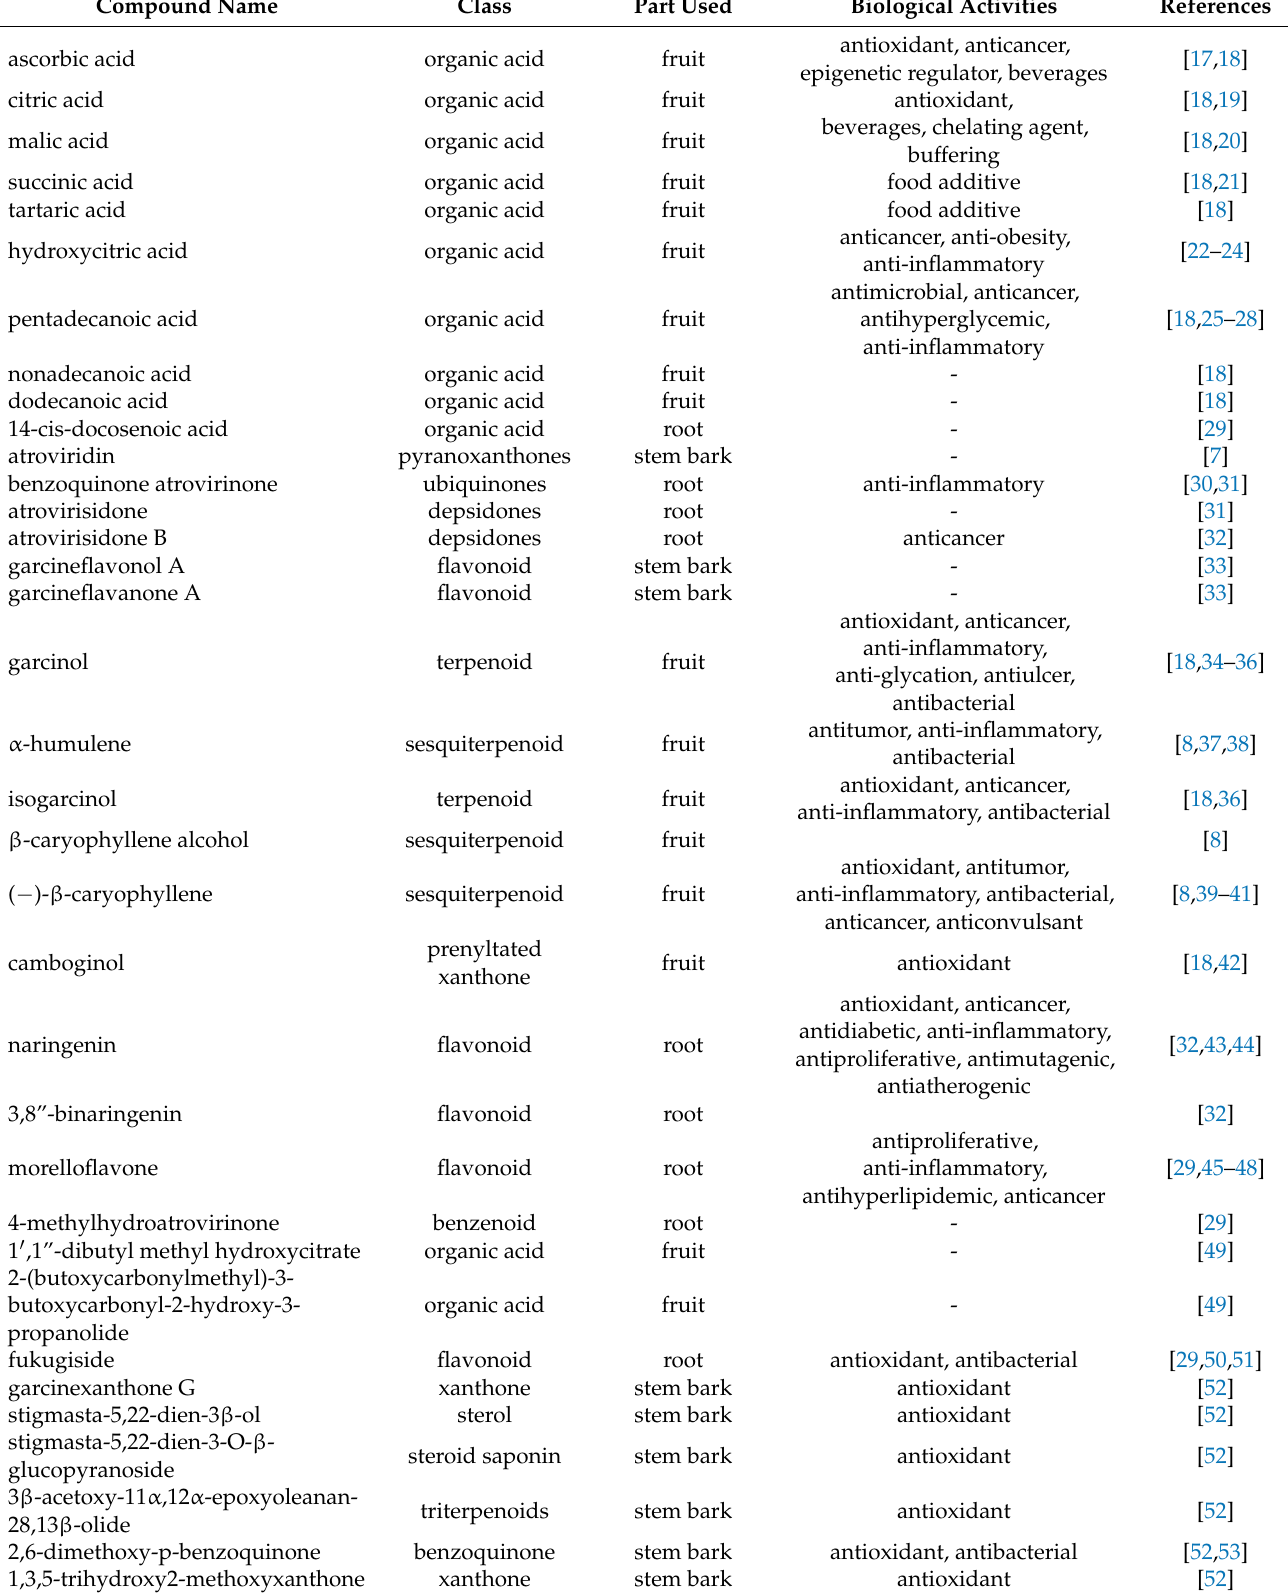
Table 2. Phytochemicals reported in various parts of G. atroviridis with their main biological